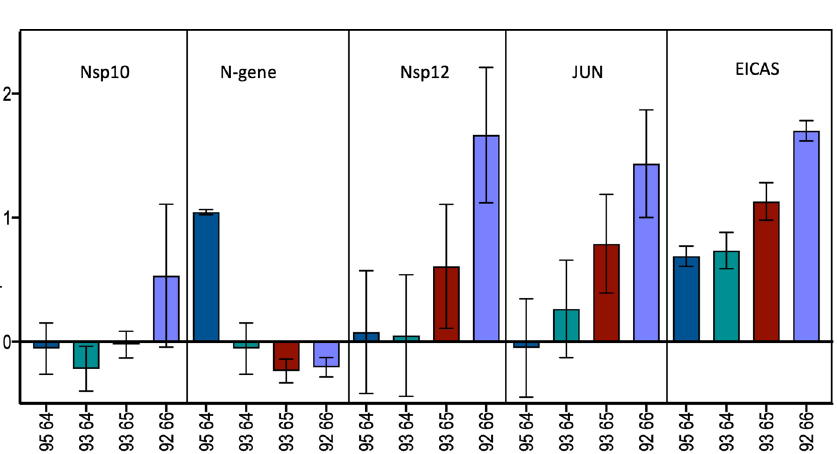
Figure 5. Reduction in denaturation and polymerisation times. The ∆Cqs for each of the five targets are plotted for each of the different temperatures used to carry out the PCR